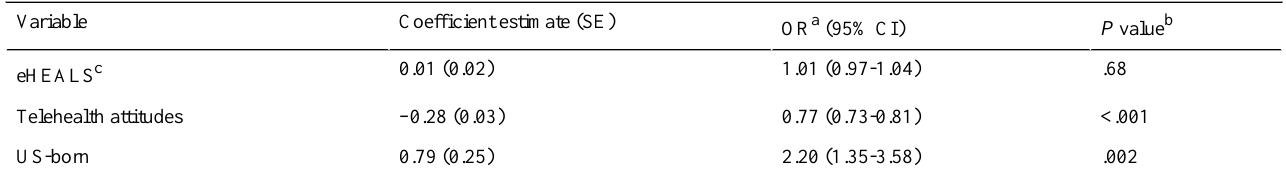
Table 2. Multivariate proportional odds regression model of factors associated with lower versus higher response to the intention to use telehealth services (n=294).